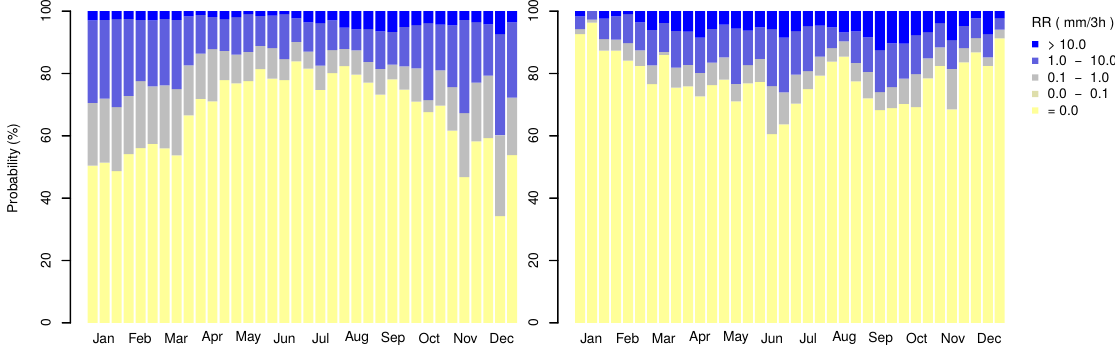
Figure 3. Frequency diagram exhibiting average classes of rainfall rates (in mm/3h) throughout an avereaged year in an approximate decadal resolution for Sapporo ( left ) and Tokyo ( right